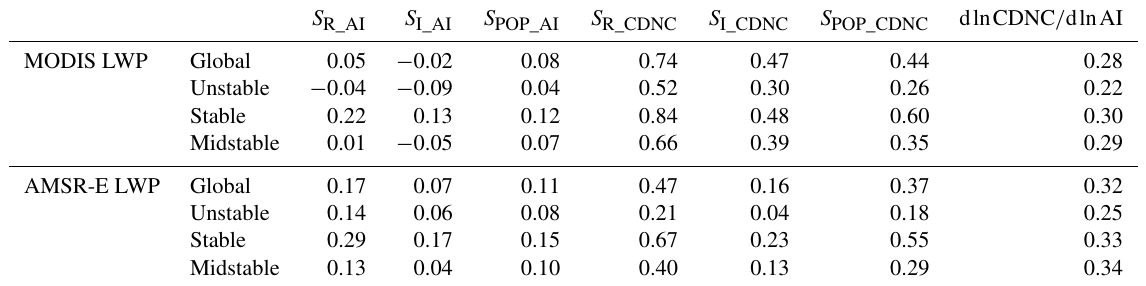
Figure 2. The probability of CDNC under given AI over the (a) global ocean, (b) unstable, (c) stable, and (d) midstable conditions. In each figure, the red line represents change in average CDNC with AI, and the lower and upper lines stand for mean CDNC for the 25th percentile and 75th percentile of samples. AI and CDNC are estimated from MYD04 and MYD06, respectively. Table 3. The LWP weighted-mean values of precipitation susceptibility S X_Y and dlnCDNC / dlnAI over global oceans under different stability regimes. The statistics are based on the 2B-GEOPROF/CPR product using the cloud base Z – R relationship and a − 15dBZ